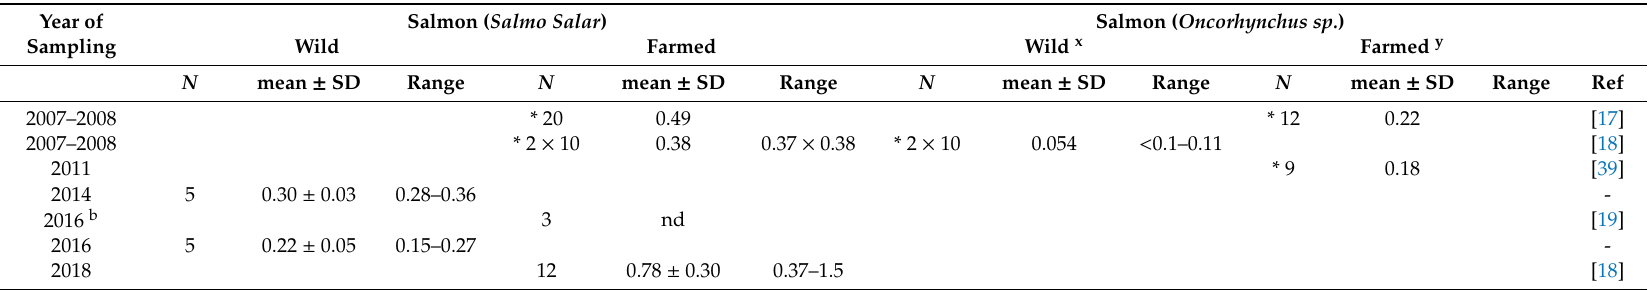
Table 2. Content of 25-hydroxyvitamin D 3 ( µ g / 100 g fillet) of Atlantic salmon ( Salmo salar ) and Pacific salmon ( Oncorhynchus sp. ) from 2007–2018, either wild or farmed. If published, sampling year, number of samples (either analysed in single or as composite samples), mean ± SD and range are included. Year of Salmon ( Salmo Salar ) Salmon ( Oncorhynchus sp.